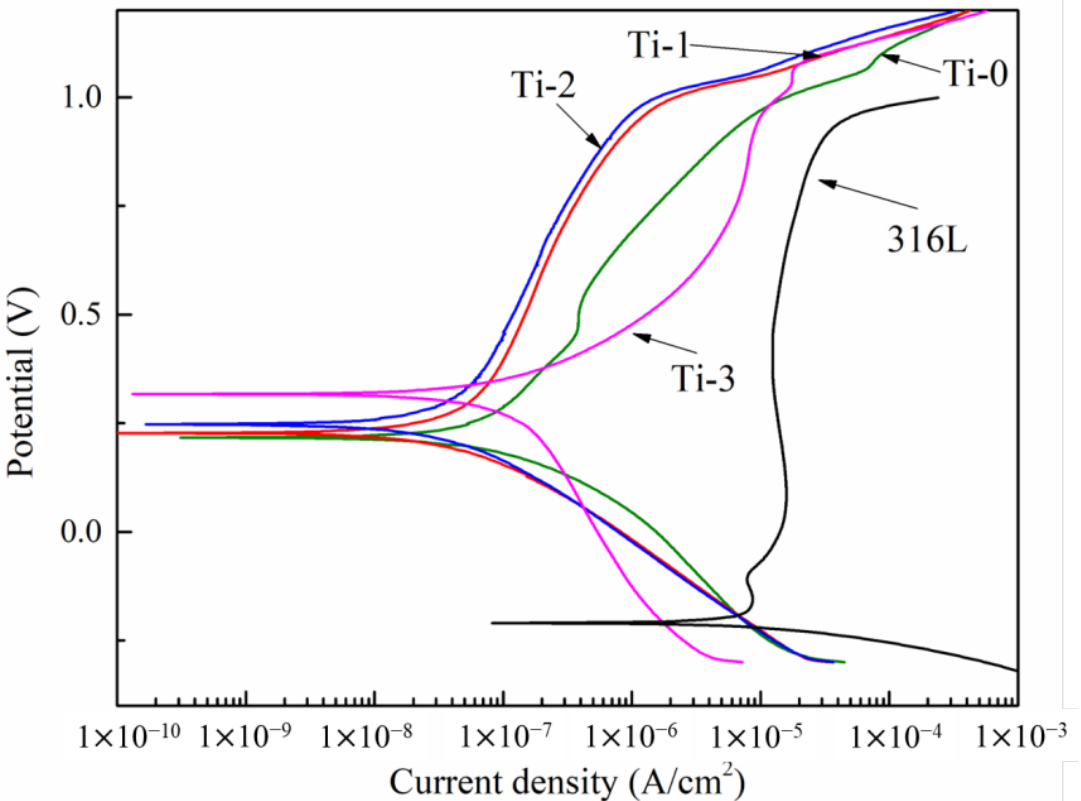
Figure 6. Potentiodynamic polarization curves of sample in the environment of PEMFCs. Table 1. Electrochemical parameters of all the samples calculated by potentiodynamic polarization curves.